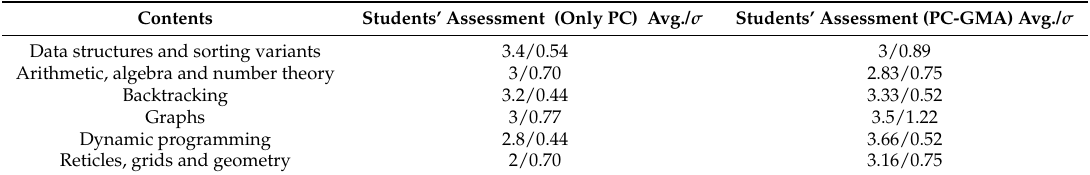
Table 1. Average assessment values and standard deviation of the importance of the contents of Programming Contests (PC) by students who took PC only and those who took both PC and Graphs, Models and Applications